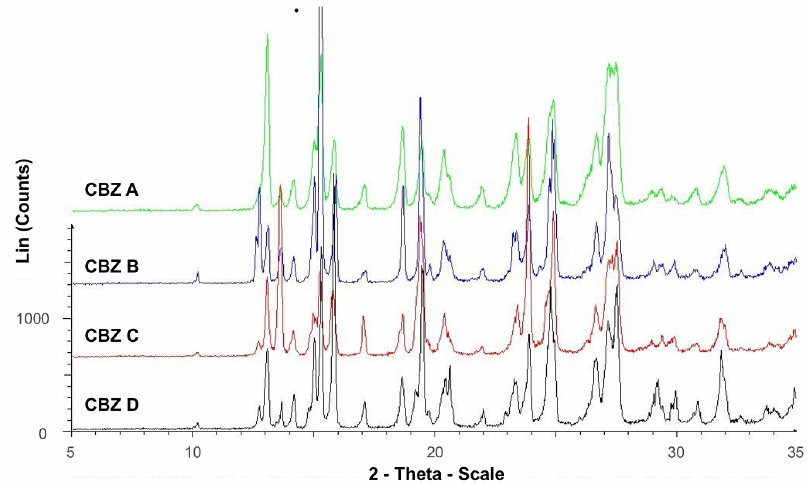
Figure 2. X-ray powder diffraction of untreated CBZ A, B, C and D.